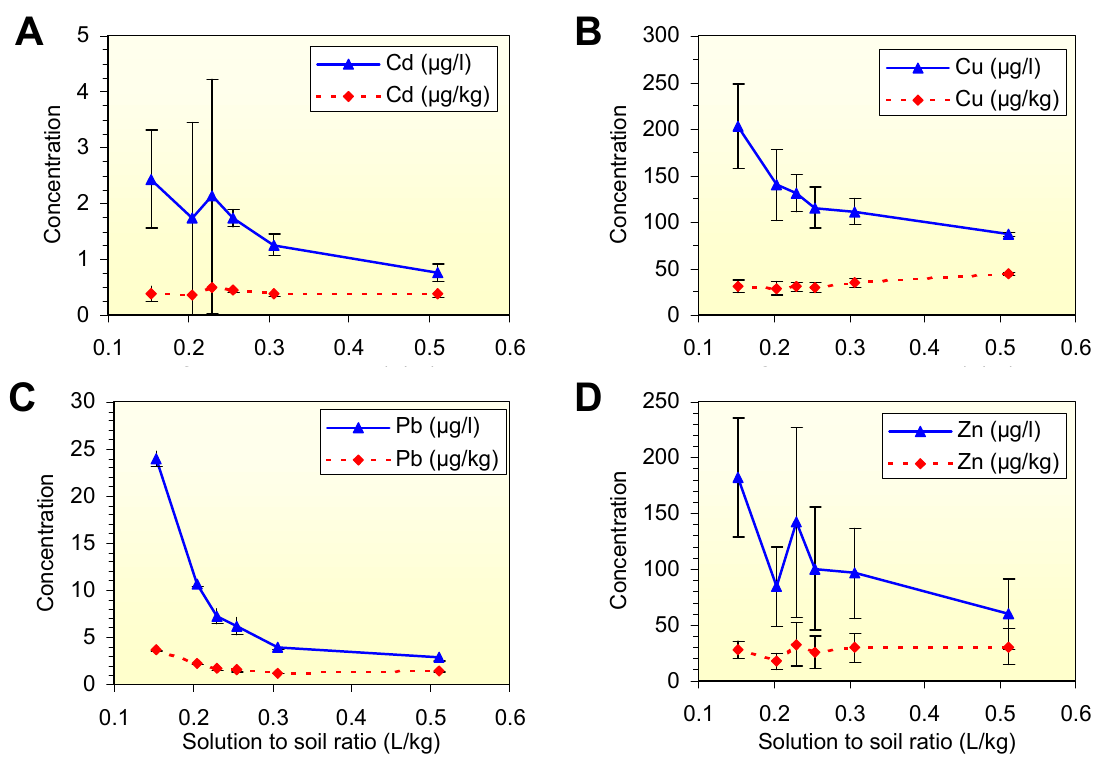
FIGURE 2 . Concentrations in aqueous extracts (solid lines) and extracted amounts (dotted lines) of Cd, Cu, Pb, and Zn as a function of extraction ratio. Error bars denote the standard deviation ( n = 3).